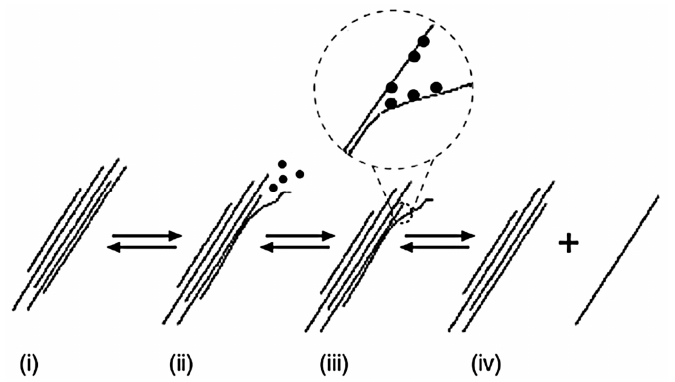
Figure 13. Mechanism of nanotube isolation from bundle obtained by sonication and surfactant stabilization: ( i ) nanotubes bundle; ( ii ) providing high local shear by sonication; ( iii ) surfactant adsorption; ( iv ) separation of the individual nanotube from the bundle [48]. Reproduced with permission of [48]. Copyright American Scientific Publishers, 2003.